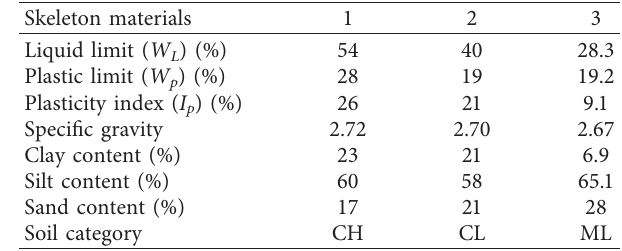
Figure 1: Photograph of the appearance of the textile sludge sample: (a) unbroken surface of the untreated sample, (b) interior of the untreated sample, (c) shape after being dried, and (d) burning in the muffle furnace. Table 1: Physical properties of the textile sludge sample. Table 3: Physical properties of the skeleton